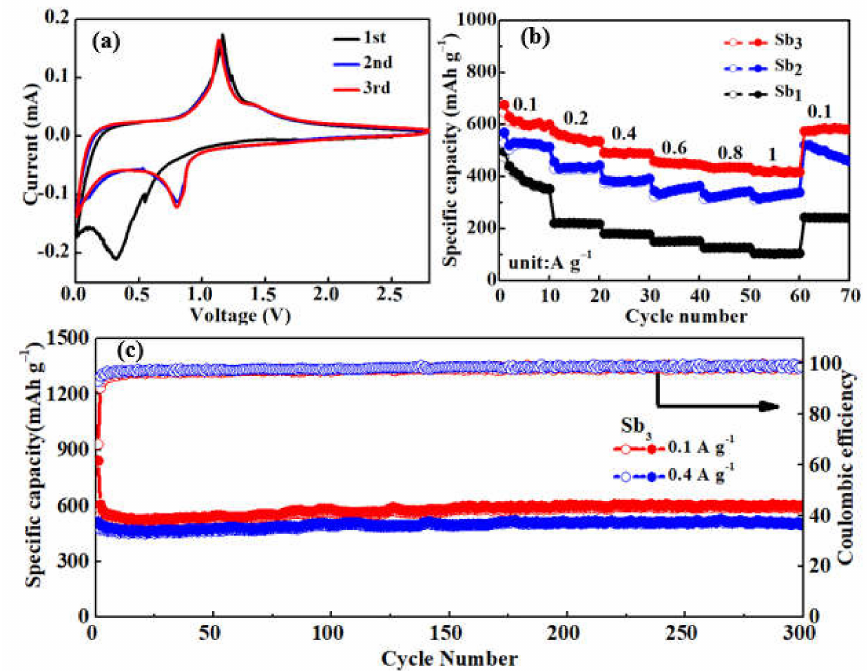
Figure 5. ( a ) CV curves of Sb 3 , ( b ) rate performances of Sb 1 , Sb 2 , Sb 3 , galvanostatic discharge–charge cycles of Sb 3 at a current density of ( c ) 0.1 Ag − 1 and 0.4 Ag − 1